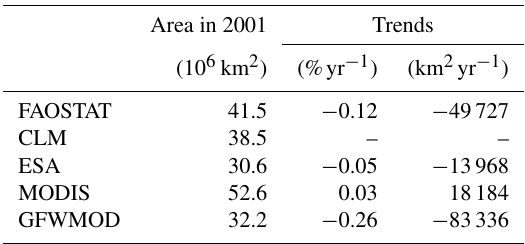
Table 3. Global TC areas (in10 6 km 2 ) in the year 2001 and trends (in % yr − 1 and in km 2 yr − 1 ) over 2001–2016 based on FAOSTAT, the static land cover map (CLM), and the satellite products (ESA, MODIS, and